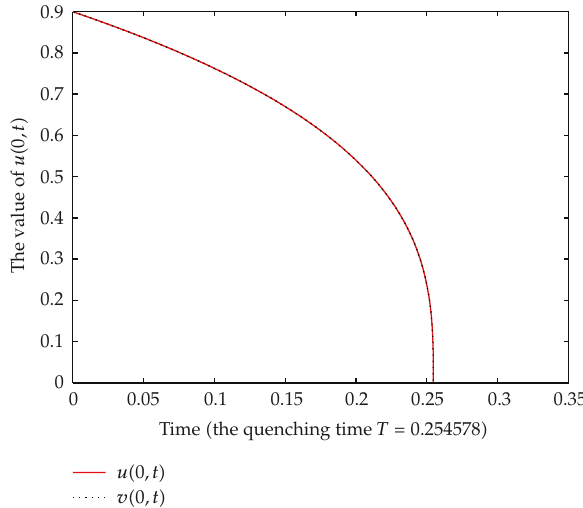
Figure 8: Evolution at the point x 0 (cid:3) 0 of the solution (cid:5) p 1 (cid:3) q 1 (cid:3) p 2 (cid:3) q 2 (cid:3) 1 (cid:6)